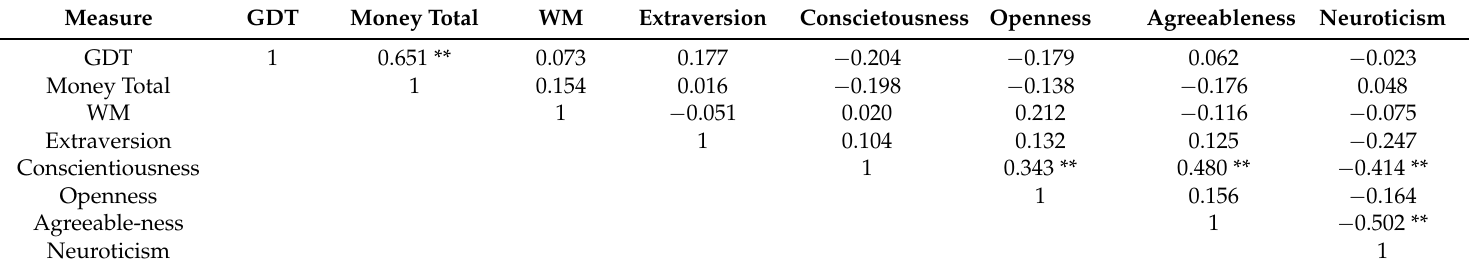
Table 5. Correlations between GDT, money total, working memory, and personality in older adults.